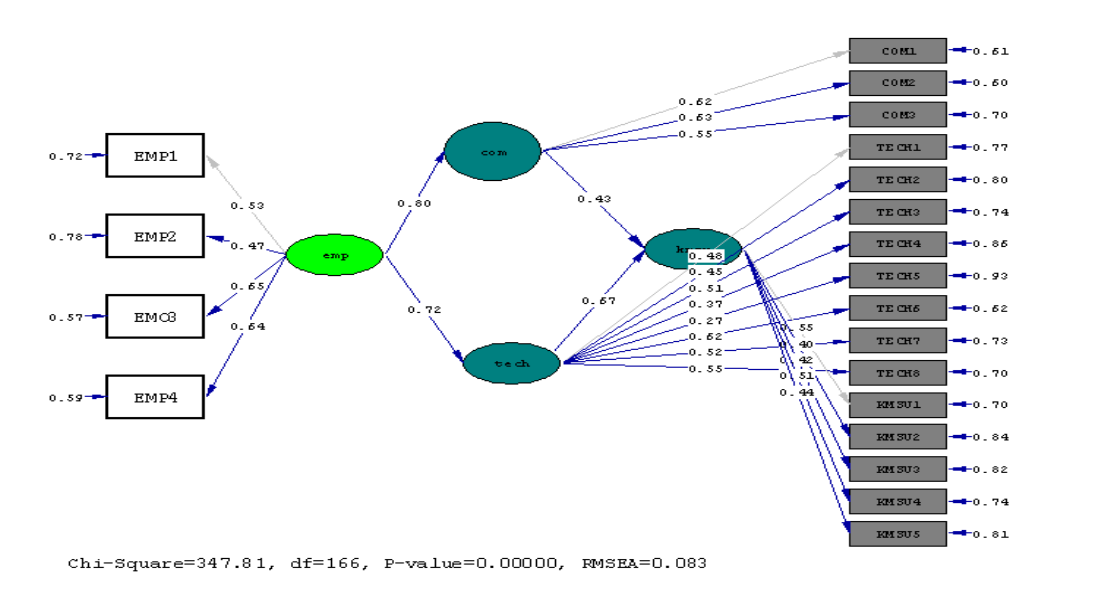
Fig. 2. T-student values